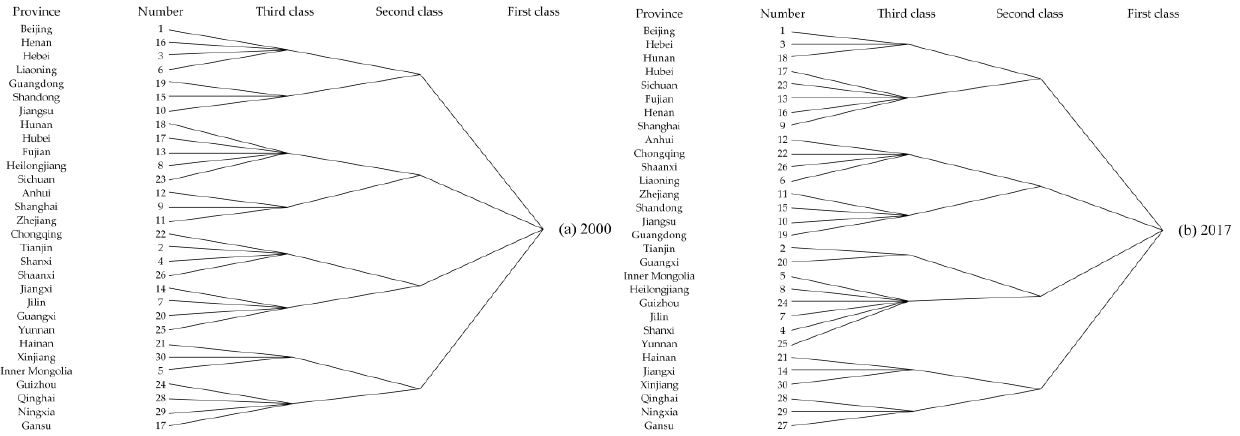
Figure 7. Subgroup of the tourism eco-efficiency network in China in year 2000 ( a ) and 2017 ( b ).